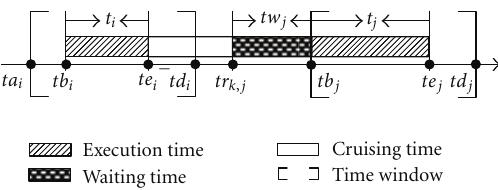
Figure 3: The waiting time between the successive key